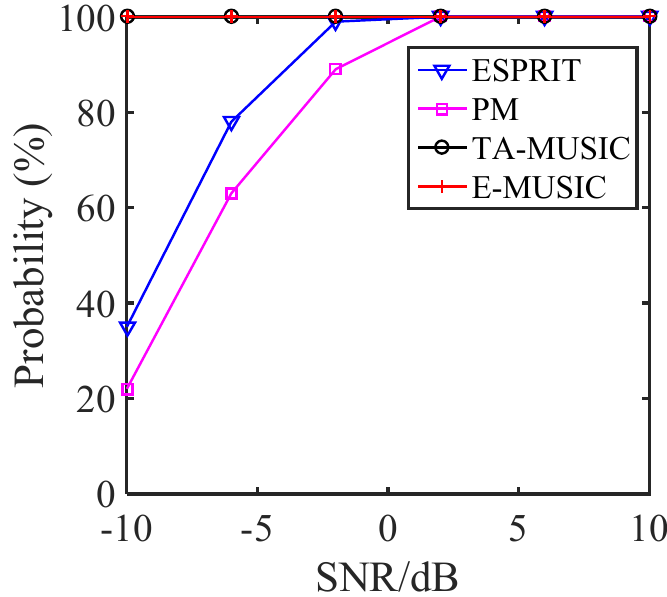
Figure 11. Resolution against SNR for various algorithms.